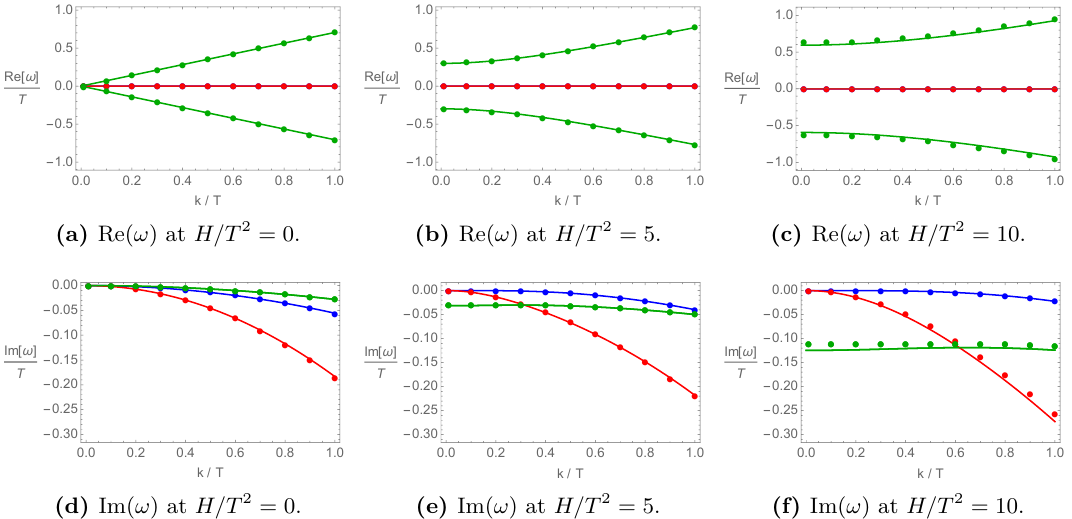
Figure 2. Quasi-normal modes vs dispersion relations from hydrodynamics at finite density ( µ/T = 5 ). Left: (a) and (d) at H/T 2 = 0 . Center: (b) and (e) at H/T 2 = 5 . Right: (c) and (f) at H/T 2 = 10 . All figures: colored dots are numerically computed quasi-normal modes and solid lines are dispersion relations from hydrodynamics by (2.11).